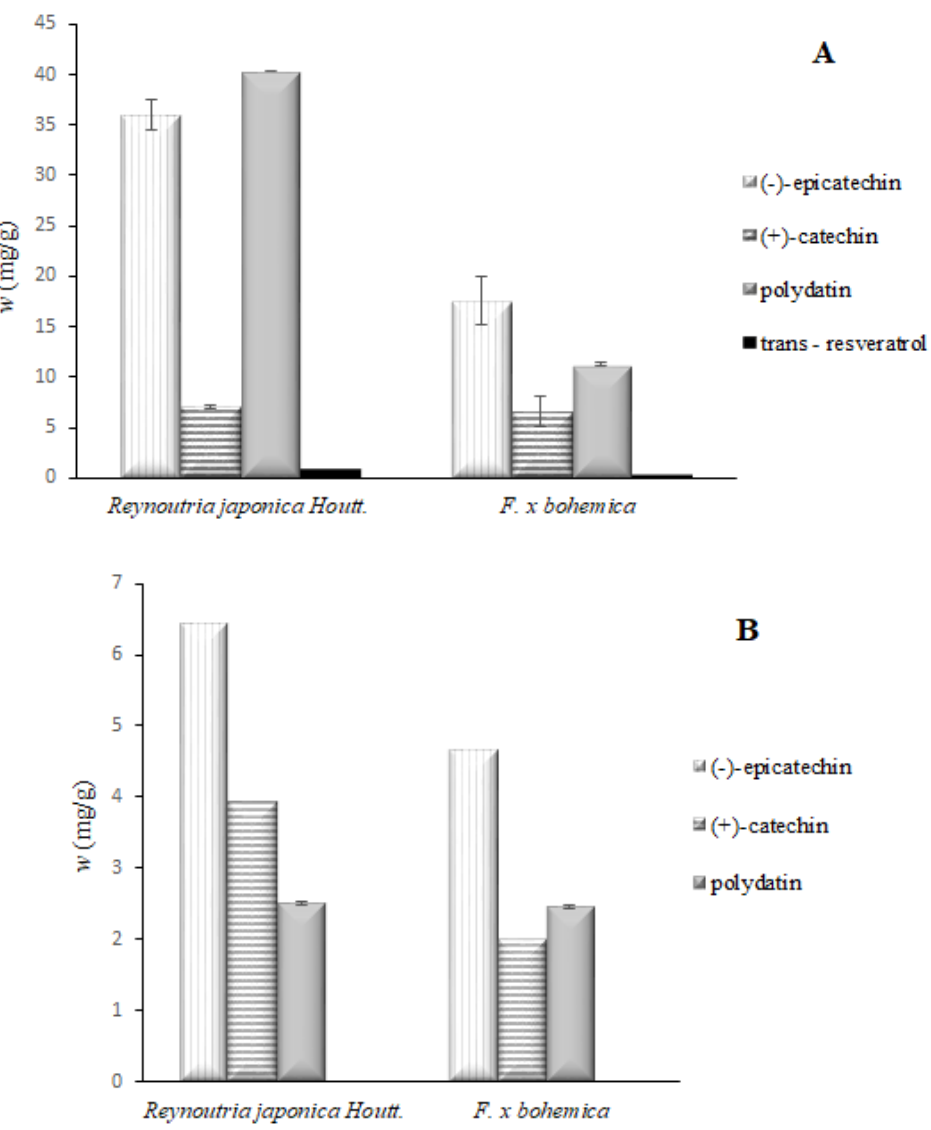
Figure 1. Mass fractions ( w ) of the investigated compounds in rhizome ( A ) and flower ( B ) extracts expressed in a mass of substance (in mg) in a gram of dry extract.